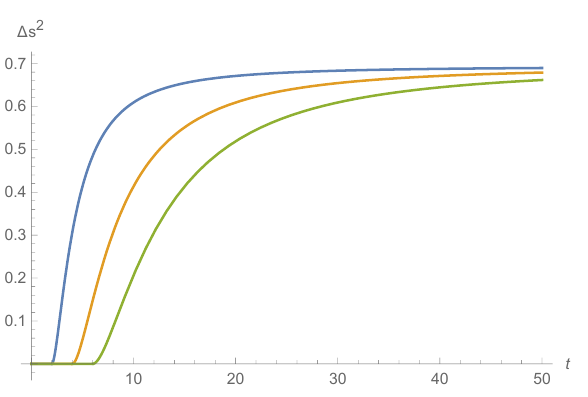
Figure 7. ∆ S (2) as a function for same components F yz of the field strength. Blue line: x = 2 ; A orange line x = 4 ; green line x = 6 . We keep (cid:15) = 0 . 01 in all cases.